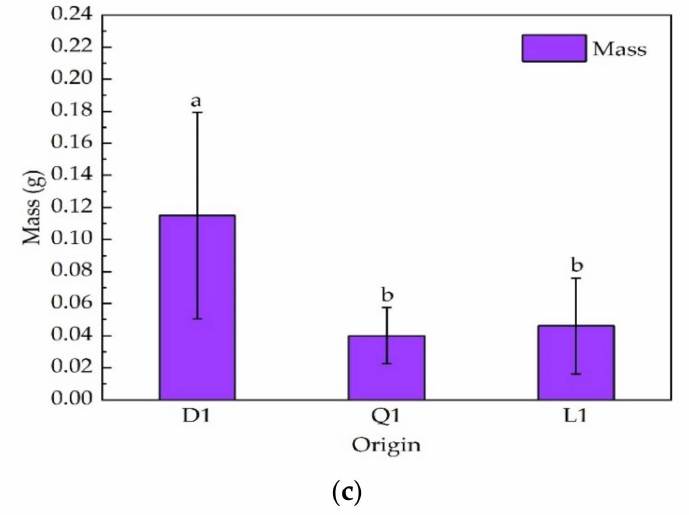
Figure 5. Biological properties of laver from different origins: ( a ) the effect of origin on length and width of laver; ( b ) the effect of origin on the thickness and length-to-width ratio of laver; ( c ) the effect of origin on the mass of laver. The different uppercase and lowercase letters indicate a significant difference between groups ( p < 0.05), while same uppercase and lowercase letters indicate no significant difference between groups ( p >